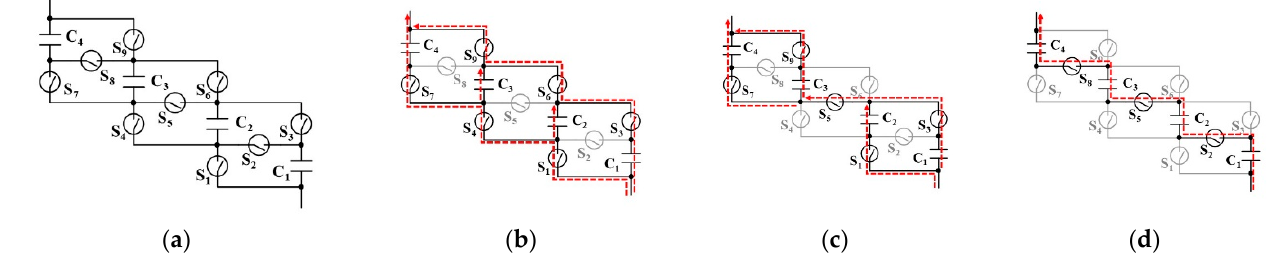
Figure 4. ( a ) Balance-shift circuit, ( b ) 1S-4P, ( c ) 2S-SP, and ( d ) 4S-1P configurations.